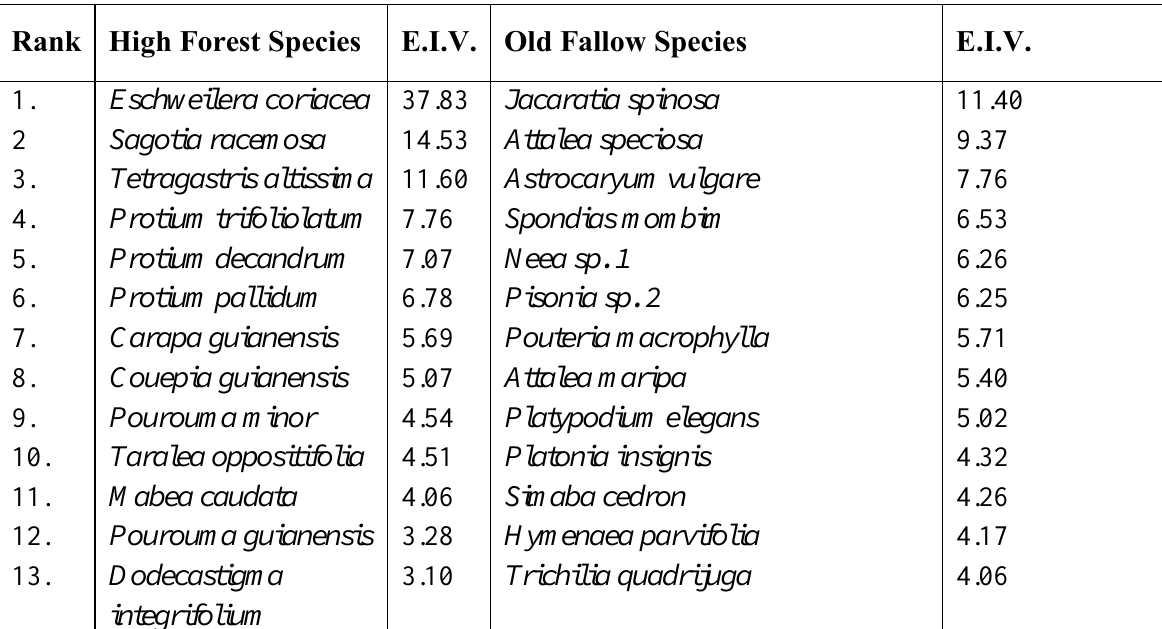
Table 1. Comparison of twenty ecologically most important tree species by Ecological Importance Value (E.I.V.) from four hectare inventories each between high forest ( ka’a-te ) and old fallow ( taper ) in Ka‘apor